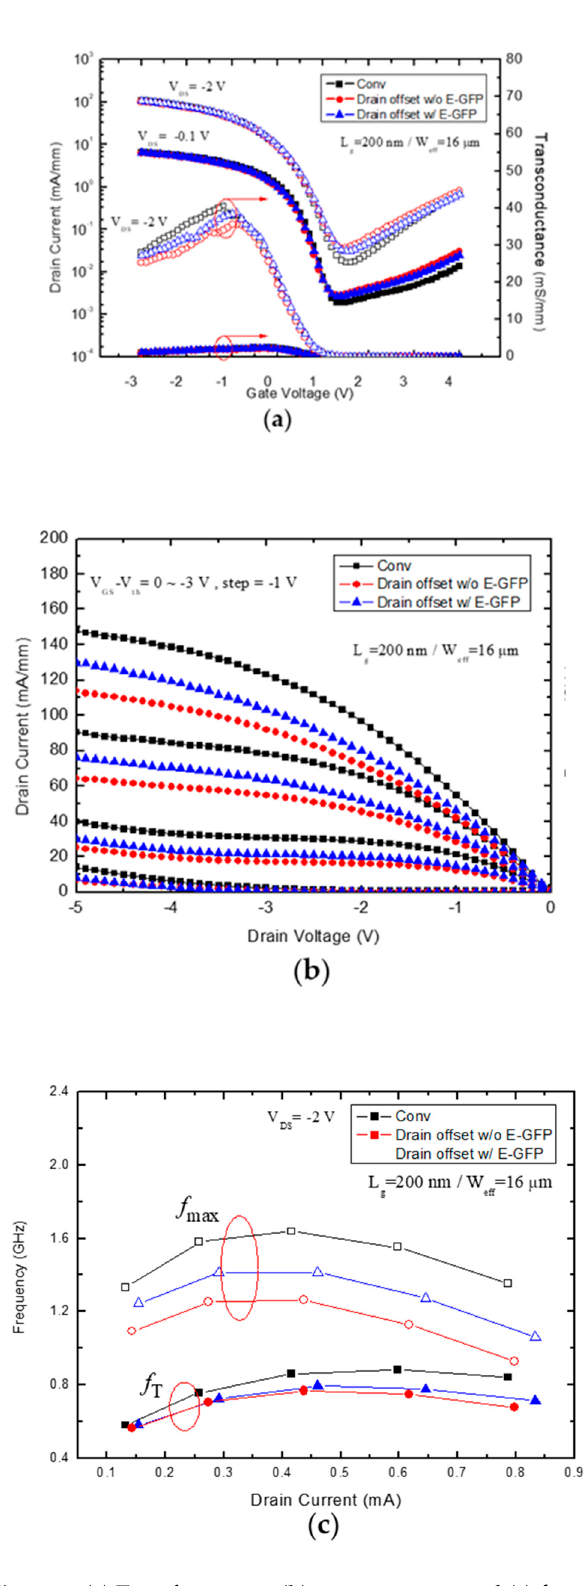
Figure 8. ( a ) Transfer curves, ( b ) output curves, and ( c ) f T and f max of various JL FinTFT after PMA in FG at 400 °C for 300 s.